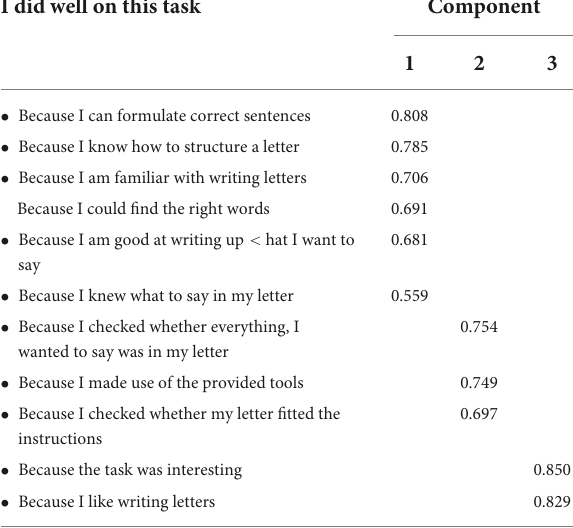
TABLE 3 Principal component analysis of the attribution items of students who perceived their writing outcome as ‘good’. I did well on this